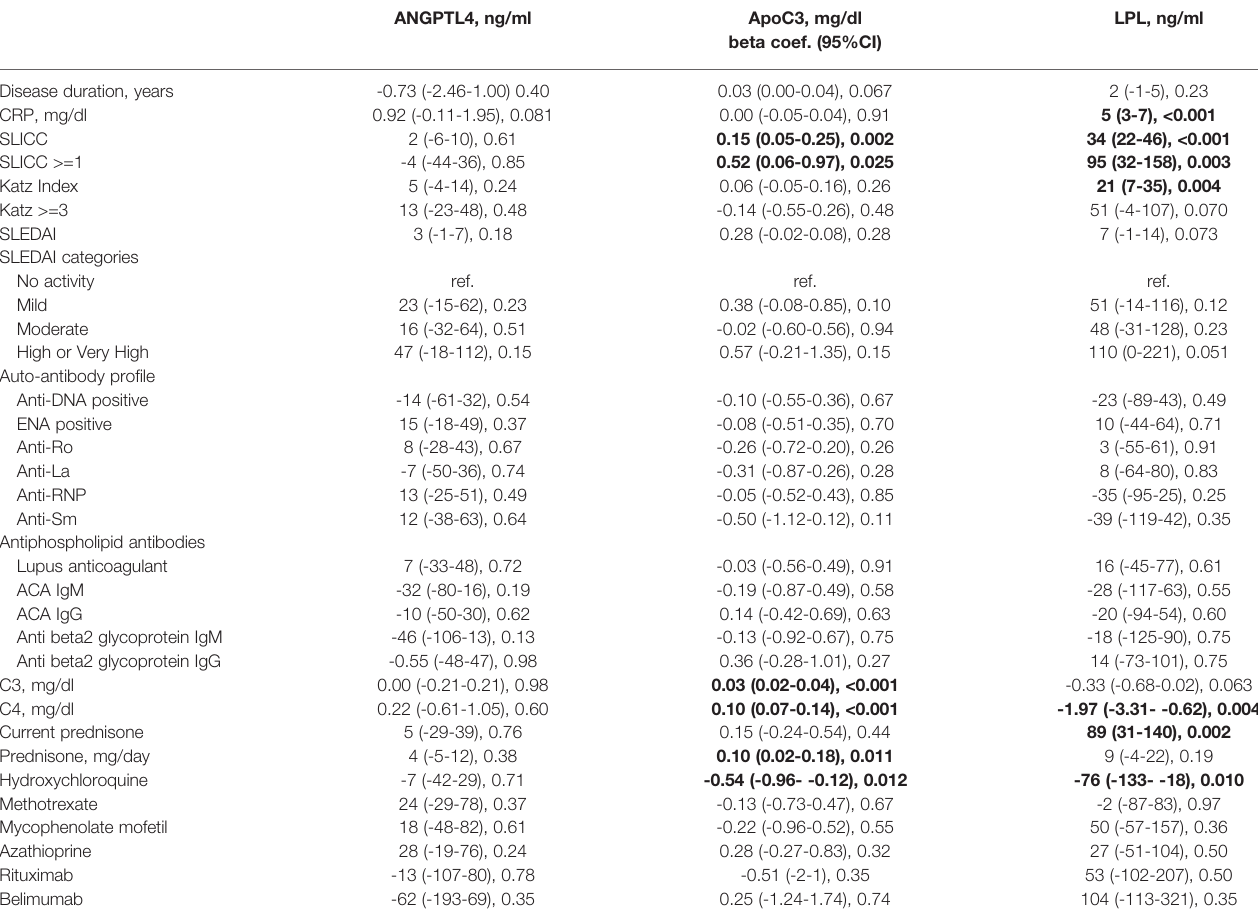
TABLE 3 | Disease related data association with triglyceride metabolism key